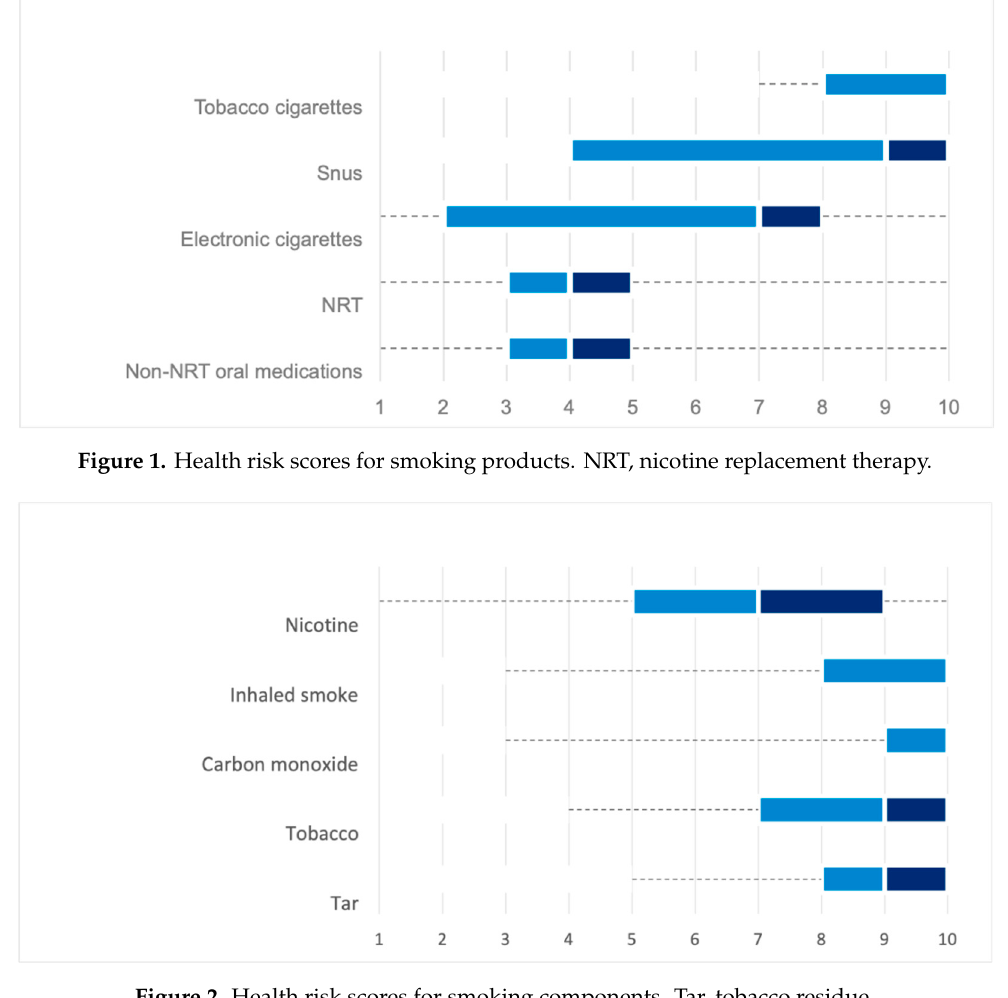
Figure 2. Health risk scores for smoking components. Tar, tobacco residue.